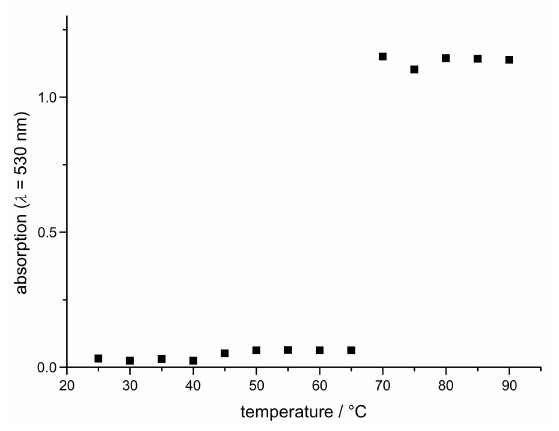
Figure 5. Temperature dependent UV/vis measurement of polyethylene-gold-nanoparticles in toluene at λ = 530 nm.